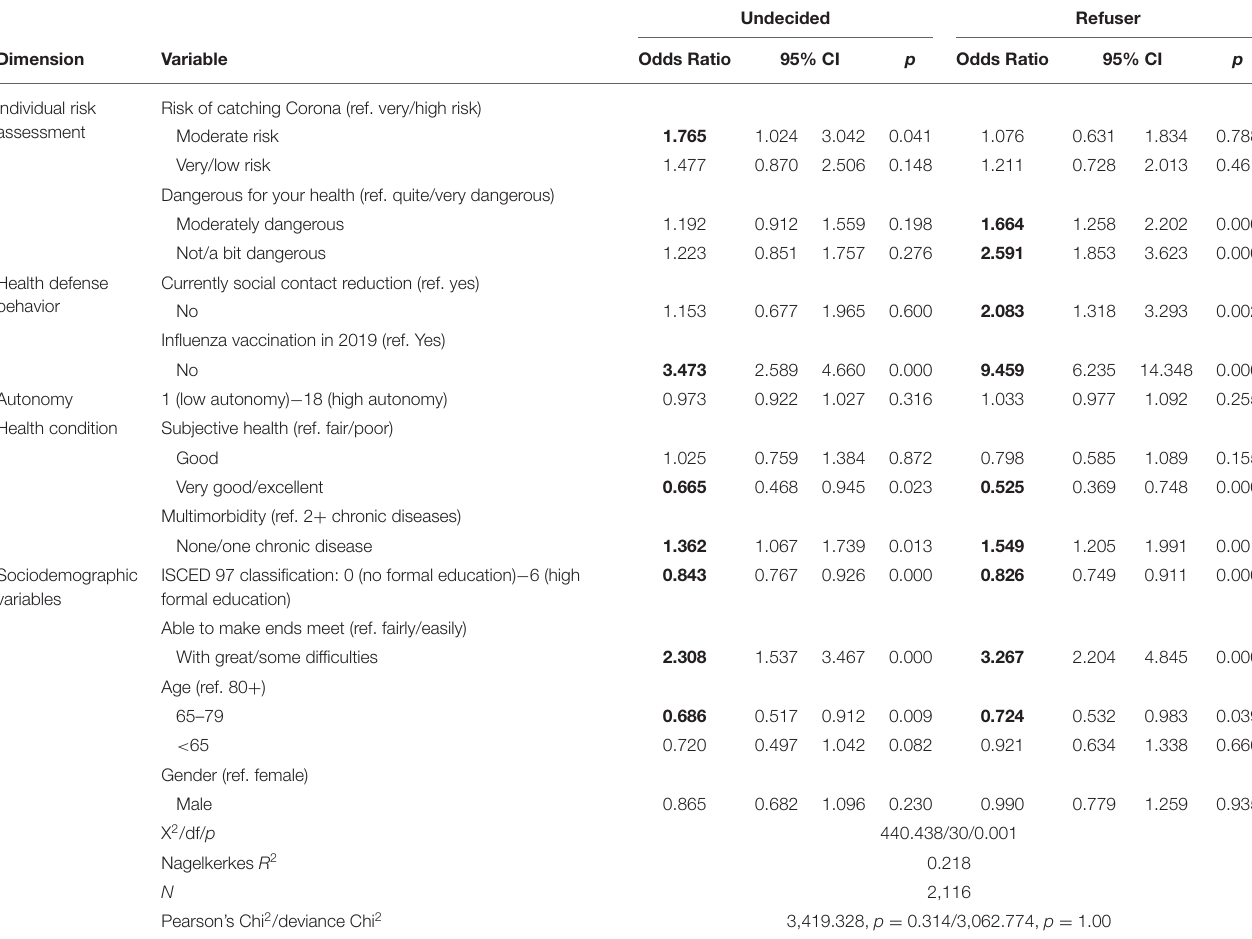
TABLE 2 | Multinomial logistic regression vaccination willingness (supporter vs. undecided and supporter vs.